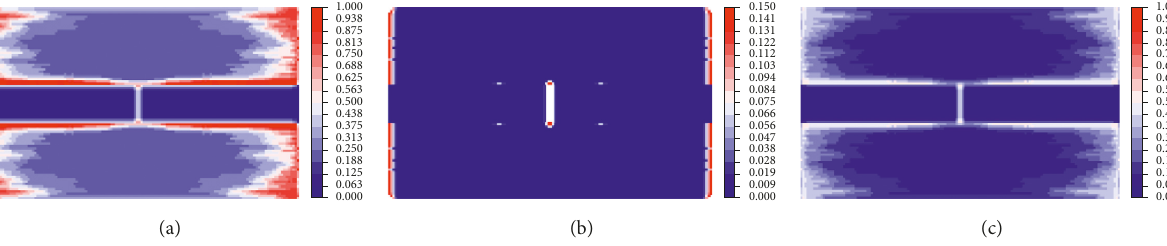
Figure 18: Failure morphology of B-0-0 specimen (damage (0-1)). (a) Matrix damage. (b) Fiber damage. (c) Total damage.